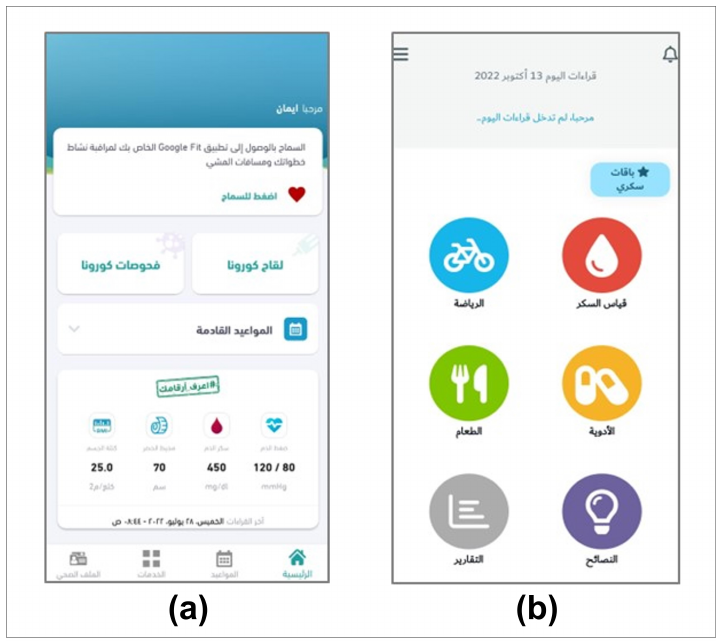
Figure 4. ( a ) The home screen of the first application. ( b ) The home screen of the second